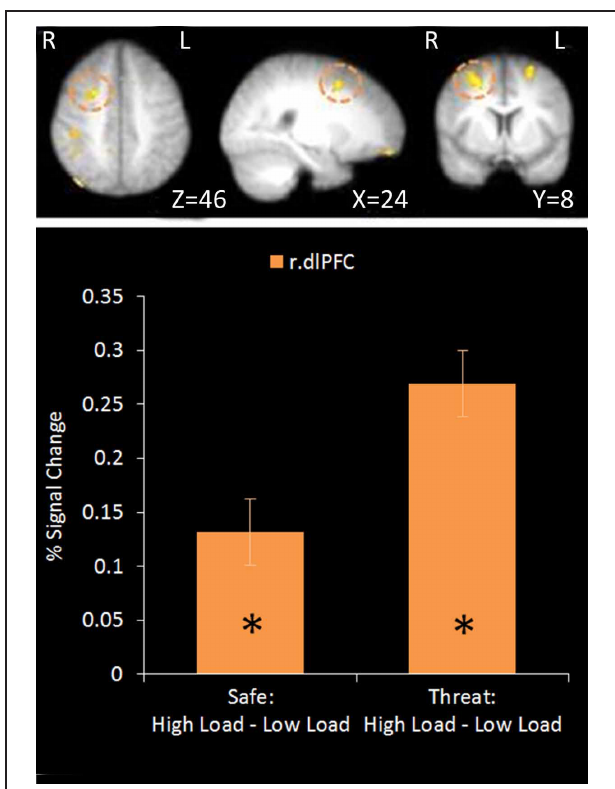
FIGURE 3 | Top: High Load—Low Load contrast imaging results. Threshold of z = 2 . 3 uncorrected. Bottom: A right dorsolateral cluster displayed greater activation under High Load compared to Low Load in both Safe and Threat trials [High Load/Safe—Low Load/Safe: mean difference = 0.121%, S . D = 0 . 178, t ( 17 ) = 2 . 880, p = 0 . 010; High Load/Threat—Low Load/Threat: mean difference = 0.162%, S . D = 0 . 188, t ( 17 ) = 3 . 656, p = 0 . 002]. Error bars display within-subject standard error (Morey, 2008). ∗ p < 0 . 05 (two-tailed).